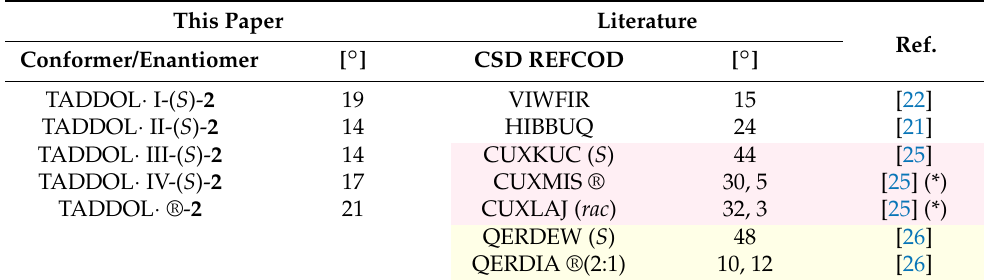
Table 3. The values of C-O. . . O-C angle in TADDOL observed in selected receptor • ligand complexes. (*)—crystal structures with Z’ =